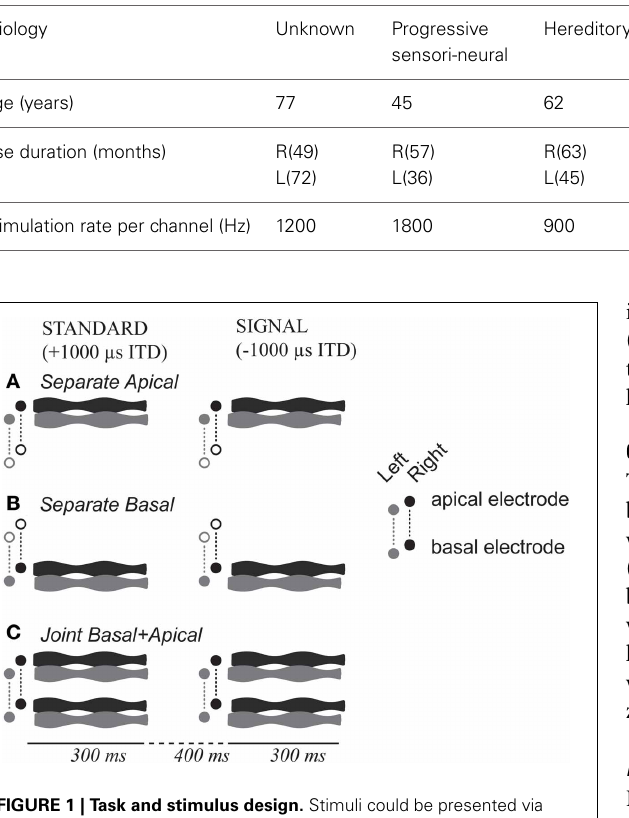
FIGURE 1 | Task and stimulus design. Stimuli could be presented via either (A) basal-only, (B) apical only, or (C) dual-site electrode configuration. The two cochlear sites are shown in the vertical dimension of each panel, left and right ear are shown in gray and black, time is shown along the horizontal